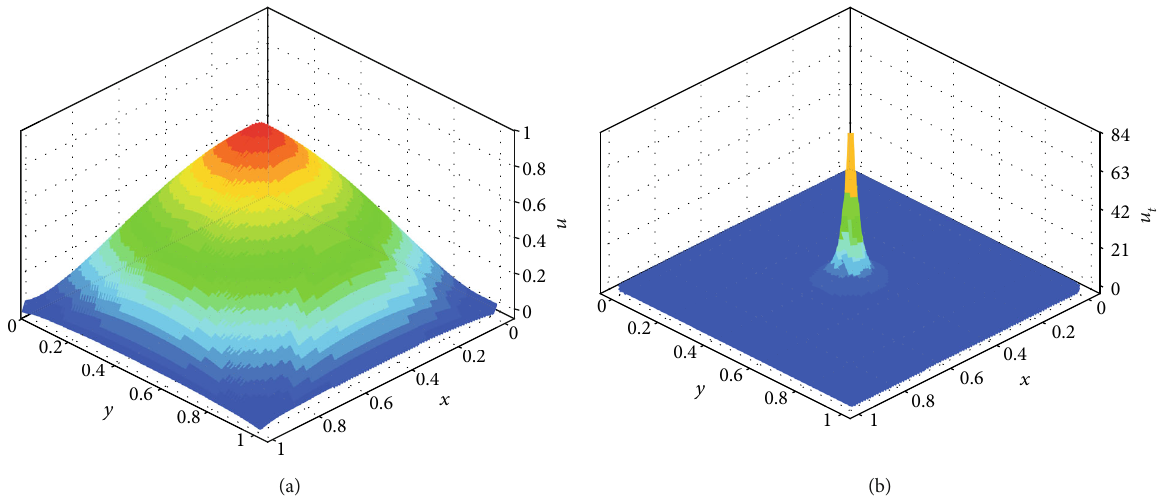
t immediately before quenching occurs. The